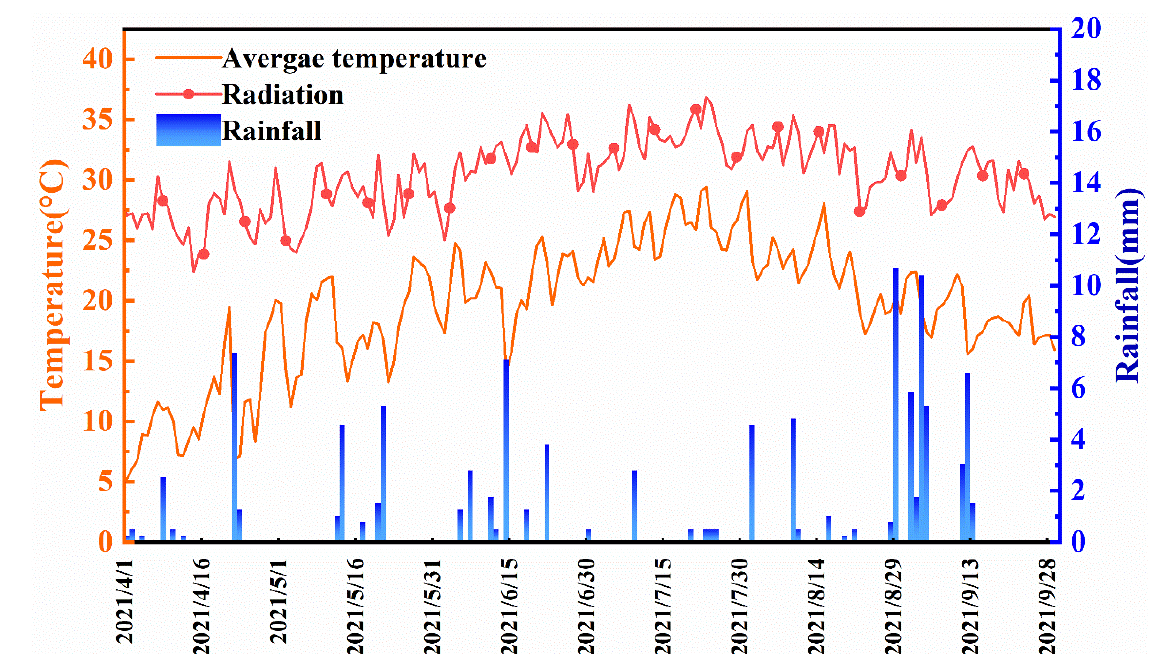
Figure 2. Meteorological radiation, temperature, and precipitation at the experimental site in Hexi arid oasis irrigation area, China. Values collected in the growing season of maize and flax in 2021 are plotted.